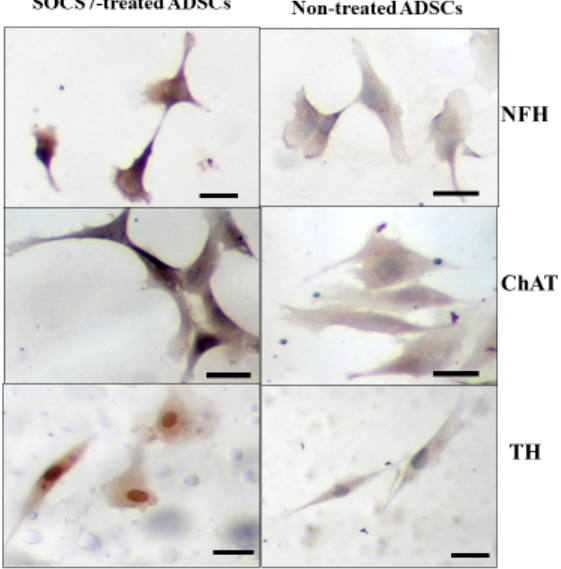
Figure 4. Immunocytostaining with anti-Neurofilament-H (NFH), choline acetyl transferase (ChAT), tyrosine hydroxylase (TH) antibodies for SOCS7-peptide-treated ADMSCs and non-treated ADMSCs. SOCS7-peptide treated cells showed immunoreactive to NFH, ChAT, and TH, while non- treated cells showed negative. Scale bar = 10 μ m.